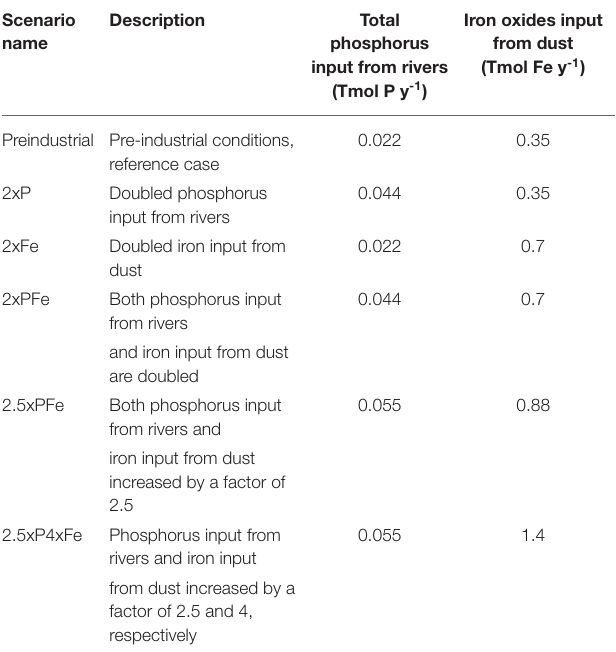
TABLE 1 | Summary of the experiments performed with the model version of Palastanga et al. (2013)